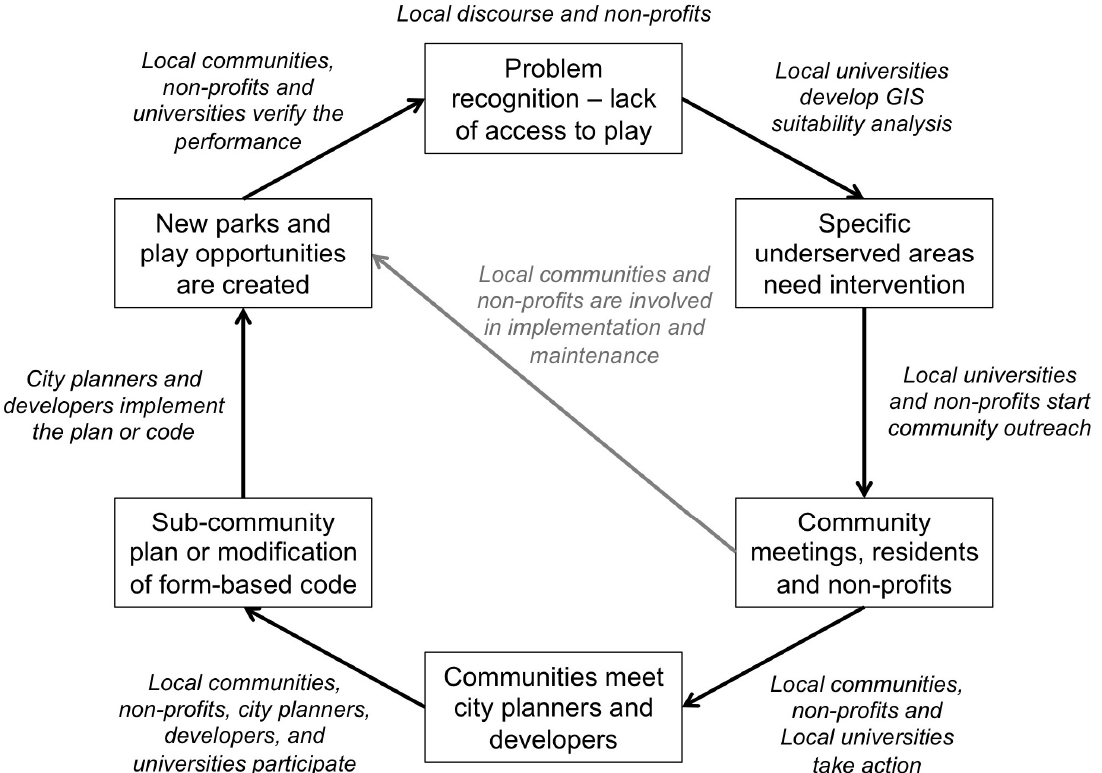
Figure 4. An action framework to increase young people’s outdoor play